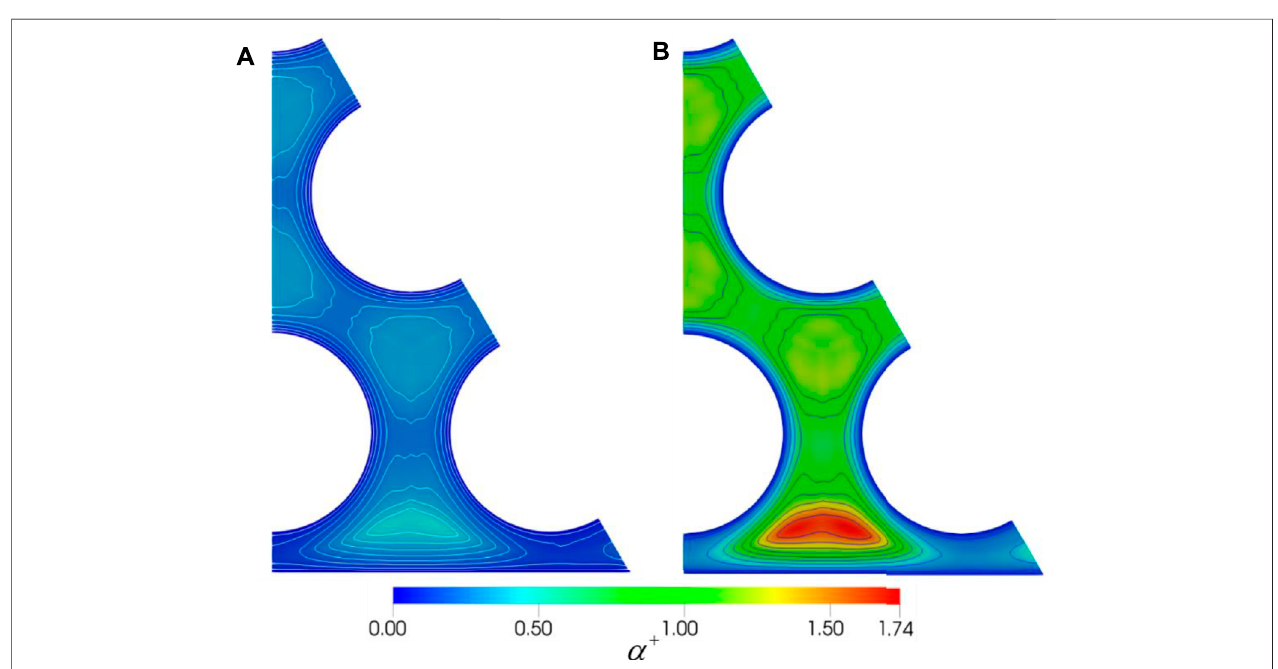
FIGURE 8 | Dimensionless thermal diffusivity distribution on a computational domain. (A) Pe bun (cid:2) 500 and (B) Pe bun (cid:2) 1500 .